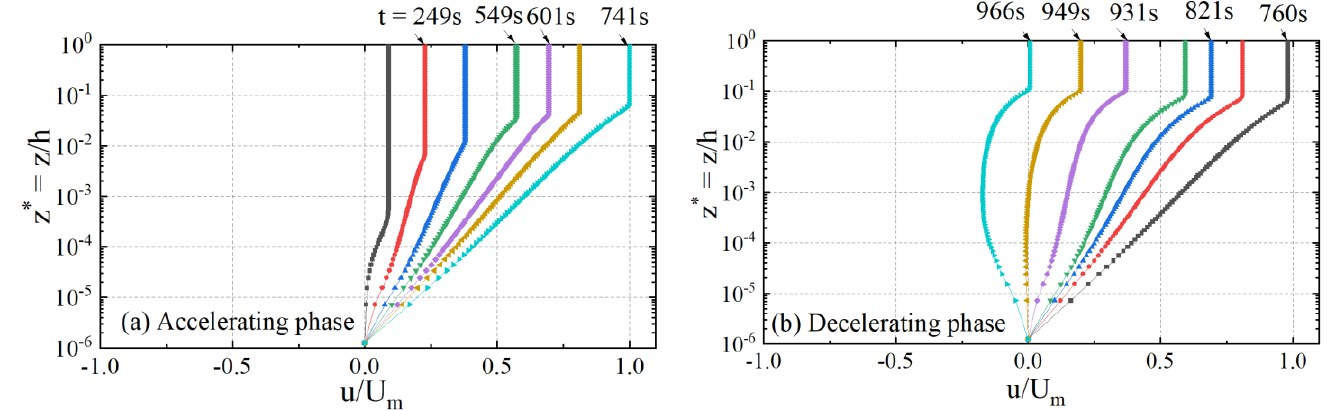
Figure 11. Flow velocity distribution under the observed tsunami at the GPS No.4 during ( a ) the accelerating phase and ( b ) the decelerating phase.